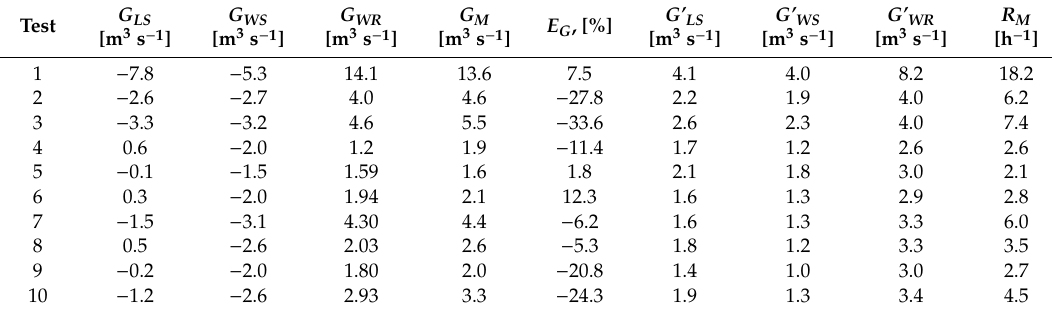
Table 4. Average values G (Equation (8)) and turbulent component G’ (Equation (9)) of the ventilation volumetric flow rates through each vent opening. Error in the calculation of ventilation volumetric flow rates E G and average values of ventilation rate R . LS , leeward side vent; WS , windward side vent; WR , windward roof vent; M , average values for the greenhouse.